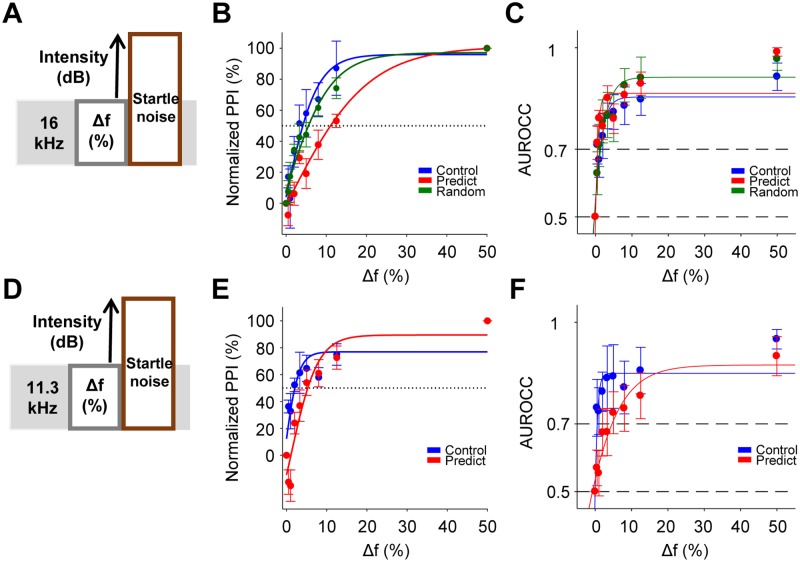
Predictable sound exposure increases behavioral spontaneous frequency
generalization but reduces trial-to-trial variability.(A) Scheme of a single PPI trial: startle noise was preceded by a
prepulse tone with a Δf of between 0% and 50% below the background tone
of 16 kHz. (B) Normalized PPI as a function of frequency change between
the prepulse and the background tone of 16 kHz for control, predictable,
and random groups. Continuous line indicates a fitted logistic function
(ANOVA, group F2,189 = 13.59, p < 0.01;
corrected pair comparisons: p < 0.001 predictable
versus control and p < 0.01 predictable versus
random). Dash line: discrimination threshold. Control n
= 7; predictable n = 8; random n = 9.
(C) Mean AUROCCs calculated from the behavioral data in B. Continuous
line indicates a fitted logistic function (ANOVA, group
F2,189 = 1.3, p = 0.27. Control
n = 7; predictable n = 8; random
n = 9). (D) Scheme of a single PPI trial with a
tone background of 11.3 kHz. (E) Normalized PPI as a function of
frequency change between the prepulse and the background tone of 11.3
kHz for control and predictable groups. Continuous line indicates a
fitted logistic function (ANOVA, group F2,81 = 18.92,
p < 0.0001; group × frequency interaction
F2,81 = 3.06, p < 0.01). Control
n = 4; predictable n = 7. (F) Mean
AUROCCs calculated from the behavioral data in E. Continuous line
indicates a fitted logistic function (ANOVA, group F2,81 =
10.36, p = 0.0019). Control n = 4;
predictable n = 7. Error bars represent SEM. Numerical
data for this figure found in S1 Data. AUROCC, area under ROC
curve; PPI, prepulse inhibition of the auditory startle reflex.